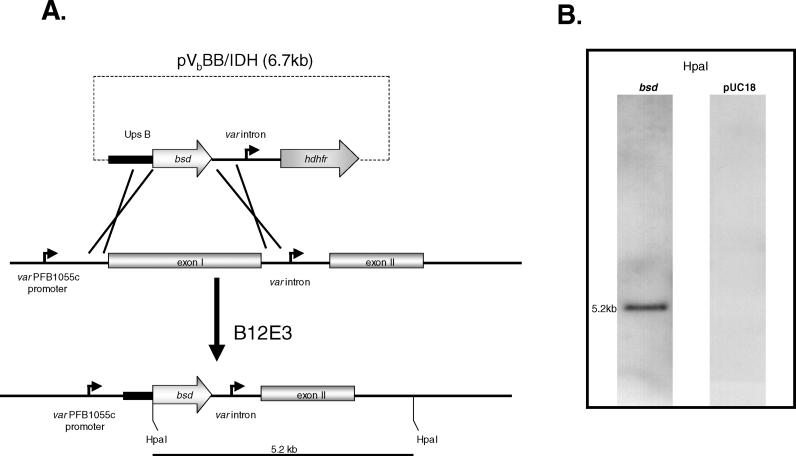
Replacement of PfEMP1 Exon I with the Selectable Marker bsd
(A) Schematic diagram showing integration of the bsd cassette from the construct pVbBB/IDH into the NF54 var PFB1055c locus through double crossover recombination.(B) Southern analysis was performed using HpaI digested DNA and probed for bsd and pUC18. The size of the DNA fragment is shown on the left. The absence of a 6.7-kb band when using a bsd probe and the absence of hybridization with plasmid backbone are indicative of a double crossover recombination event, resulting in replacement of exon I with the bsd cassette. This arrangement was confirmed by additional Southern blots and by sequencing across the sites of integration.